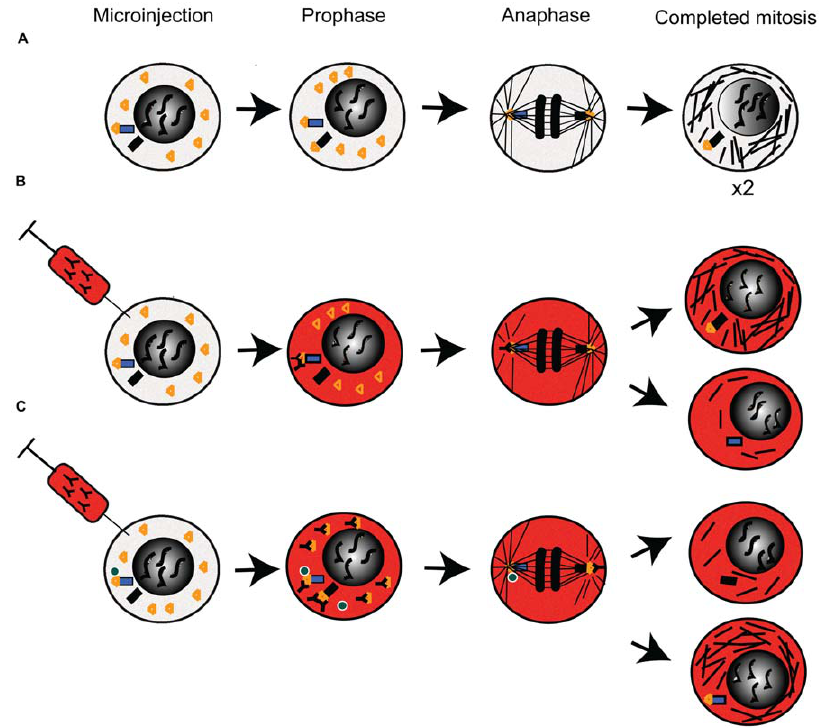
Figure 14. Models for the possible functional effects of antibody 1A11 in microinjected cells. (A) In uninjected cells EB1 (orange triangle) is initially localised to the mother spindle pole (blue rectangle) and is recruited to the daughter (black rectangle) during prophase, giving both poles functional equivalency in MT nucleation and/or anchoring during and after mitosis. (B) In microinjected cells the antibody binds preferentially to EB1 located at the mother spindle pole early in prophase and antagonises its function. The function of EB1 newly recruited to the daughter pole is not affected, leading to proper nucleation and/or anchoring of microtubules at the daughter but not the mother pole. The uneven distribution of functional EB1 at the poles leads to asymmetries in mitotic pole movement and MT content in daughter cells. (C) EB1 at the mother pole is associated with a binding partner (green circle) important for its function at this site. Antibody binding does not antagonise the function of pre-existing complexes, but it inhibits the functional associations of EB1 newly recruited to the daughter pole. This results in normal nucleation and/or anchoring of microtubules at the mother but not the daughter pole, again leading to asymmetries in mitotic pole movement and MT content in daughter cells.